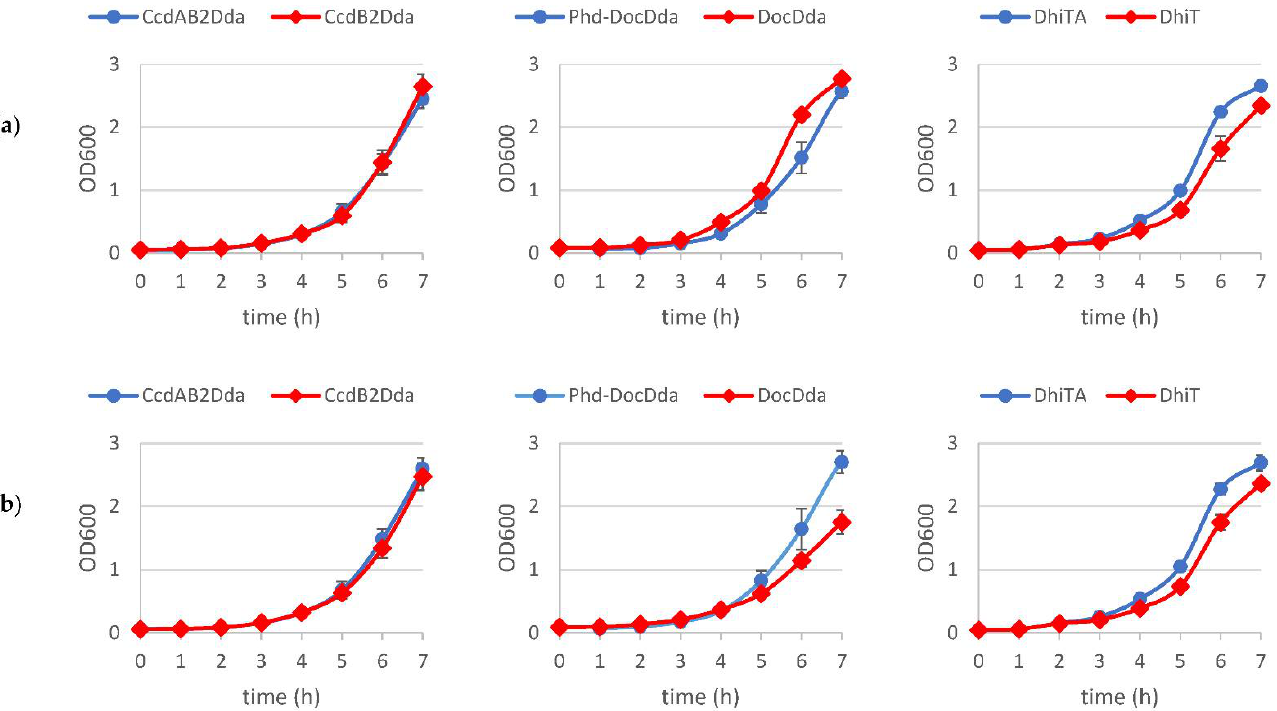
Figure 6. Effect of the induction of expression of the putative toxins on the growth of D. dadantii 3937. D. dadantii cells, harbouring plasmids encoding the toxin (red (cid:7) ) or the antitoxin-toxin (blue • ) genes under control of the P BAD promoter, were grown to OD 600 of 0.05–0.08. Each culture was then supplemented with either 0.2% D-glucose ( a ) or 0.2% L-arabinose ( b ). Culture growth was monitored by measuring OD 600 every hour. The results are an averages of at least 3 independent experiments with SD indicated.